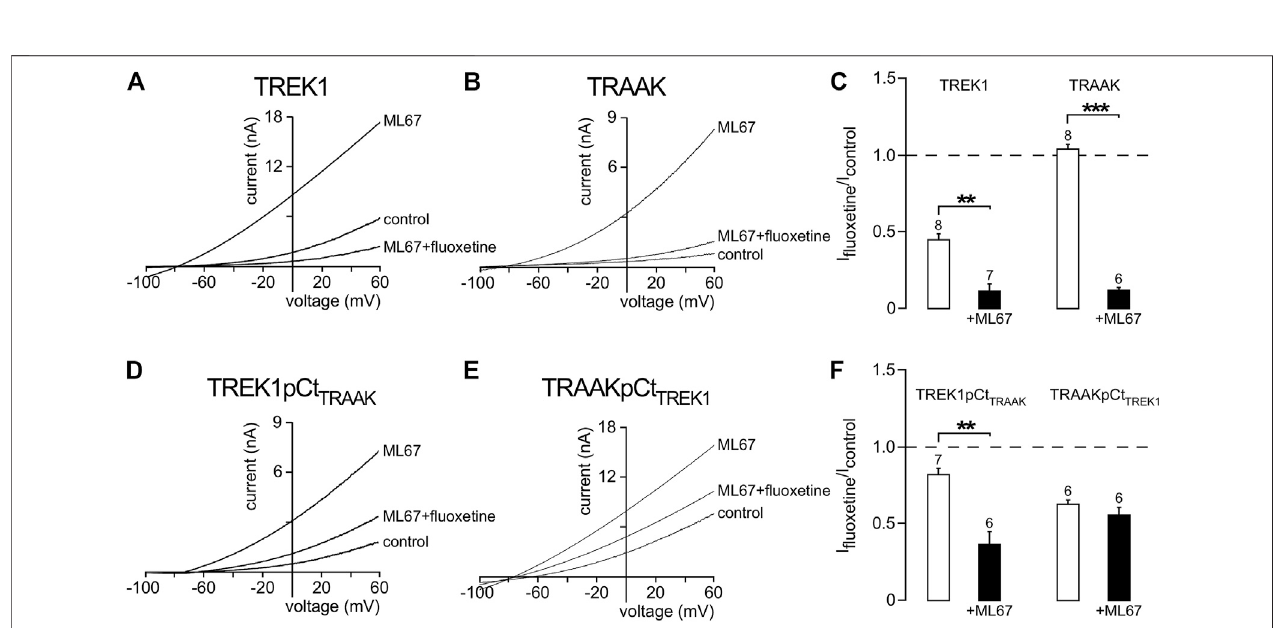
FIGURE 7 | State-dependent inhibitory effect of fl uoxetine modulated by ML67. (A, B, D, E) Representative patch-clamp recordings from HEK cells expressing wild-type or mutated channels stimulated by ML67 (100 μ M) and in the presence of fl uoxetine (10 μ M). (C, F) Fraction of fl uoxetine-sensitive current in the absence or presence of ML67 (100 μ M). Data are presented as mean ± SEM. pp p < 0.01, ppp p < 0.001, the number of cells is indicated (Mann-Whitney test).